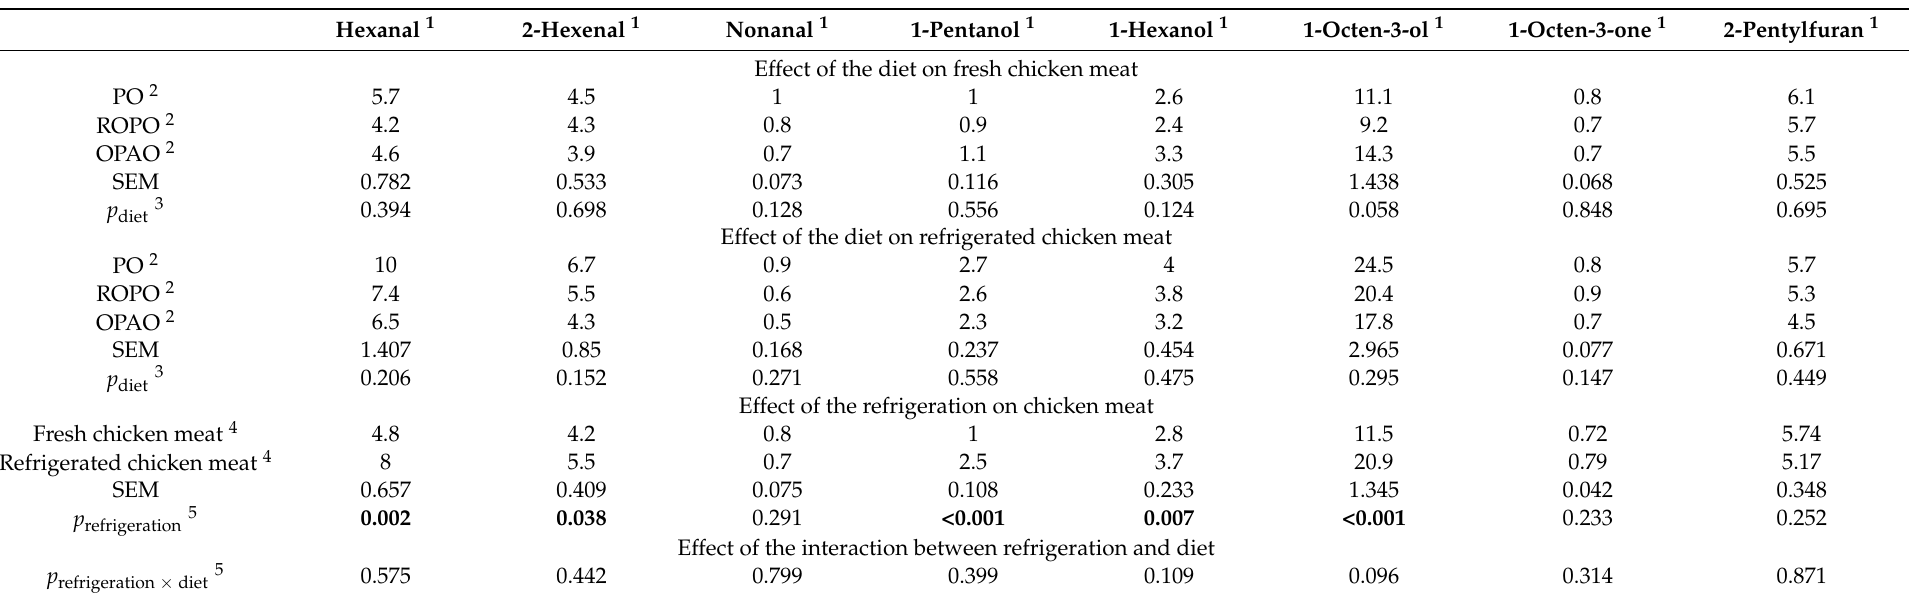
Table 6. Volatile compounds ( µ g/kg) of fresh and refrigerated dark chicken meat with